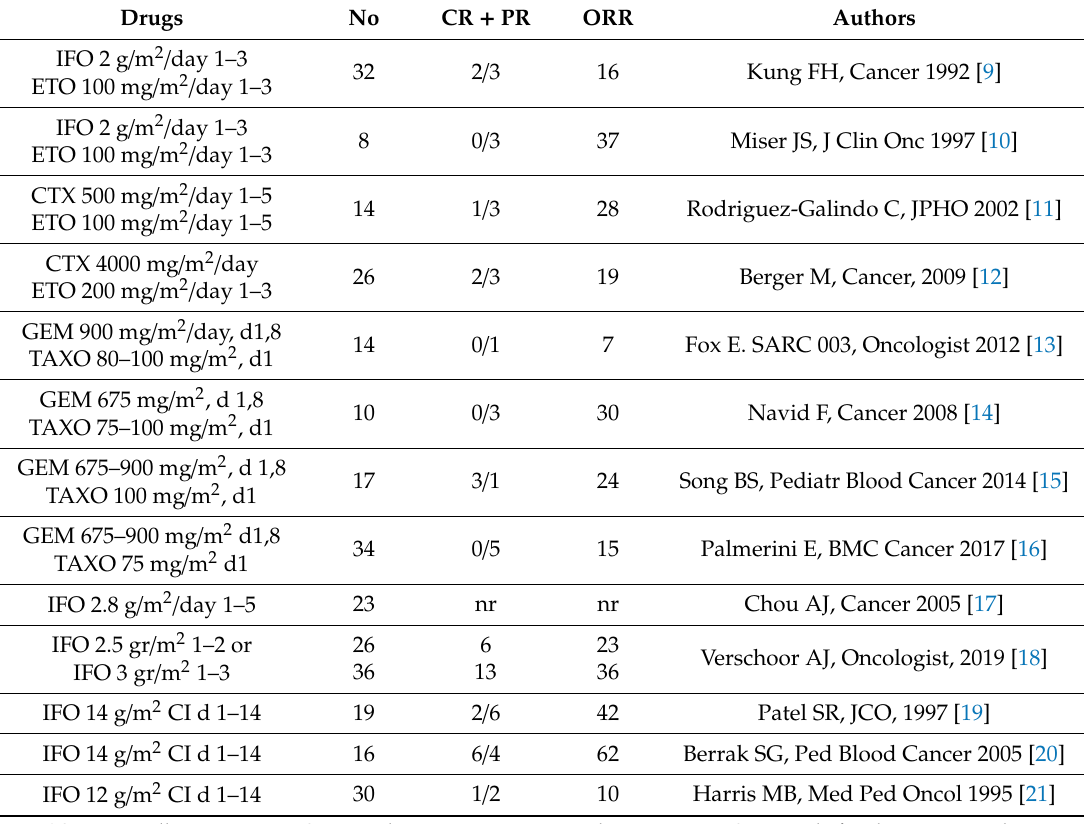
Table 1. Second-line option in patients with relapsed